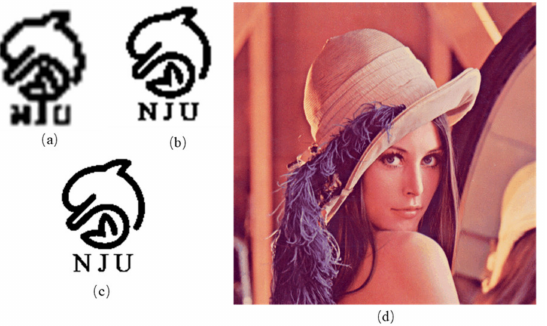
Figure 5. Watermark patterns of different sizes: ( a ) 32 × 32 watermark pattern; ( b ) 64 × 64 watermark pattern; ( c ) 128 × 128 watermark pattern; ( d ) original test